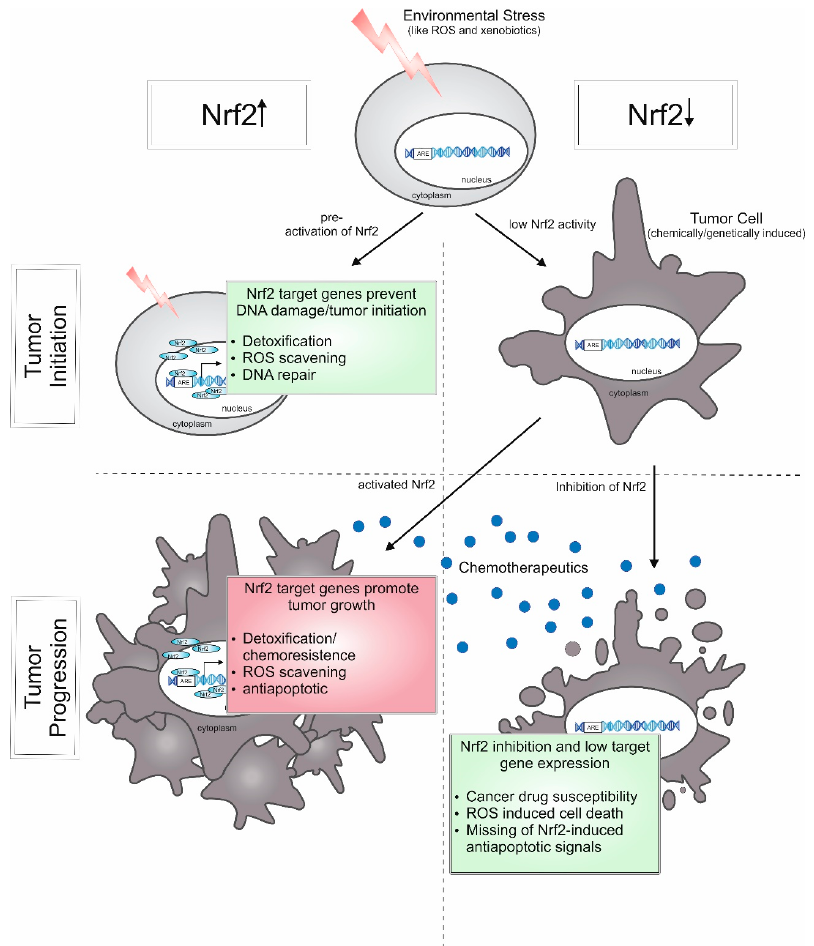
Figure 5. Roles of Nrf2 in tumorigenesis. Activated Nrf2 can prevent onset of cancer by protecting the cell from environmental stressors, like ROS and xenobiotics which can cause DNA damage. Low levels of Nrf2-target genes (reducing ROS levels and eliminating xenobiotics) can lead to tumorigenesis upon stress. In contrast, during tumor progression, Nrf2 activity can contribute to chemoresistance and the ability of tumor cells to circumvent apoptosis, whereas the inhibition of Nrf2 provokes cancer drug susceptibility and the loss of antiapoptotic signals.